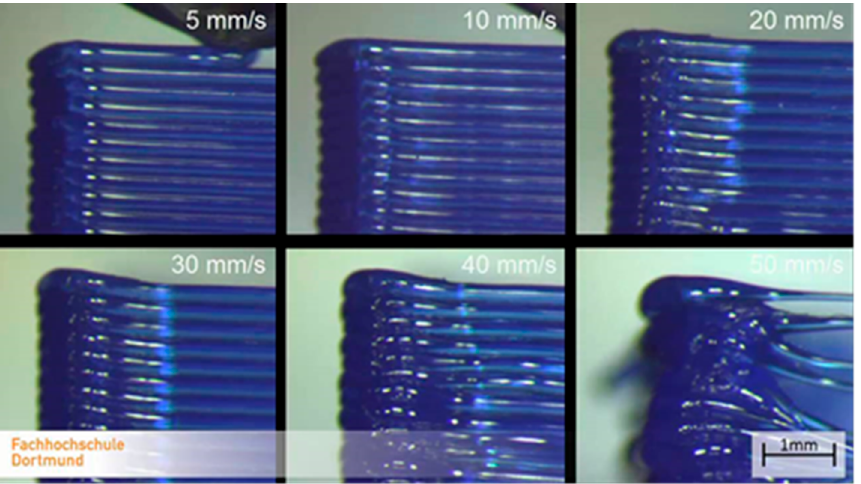
Figure 13. The speed effect on the model [43].